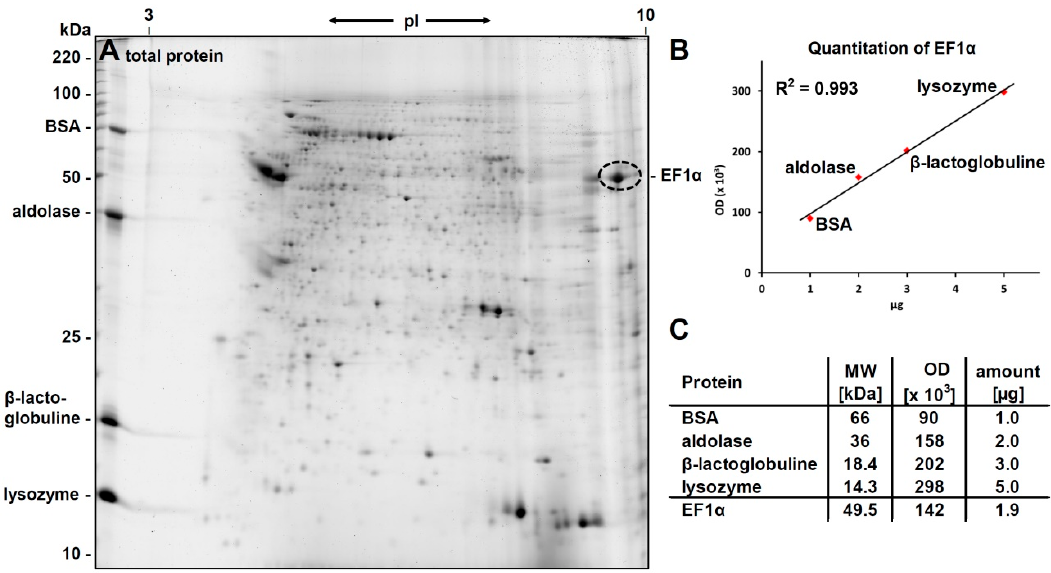
Figure 5. Quantitation of the extracted eEF1 α . ( A ) Gel stained with Flamingo for total protein visualization. To quantify individual spots by densitometric analysis, four proteins with specific amounts were run along the sample in the second dimension; ( B ) The plot shows the linear correlation of optical densities of the four proteins with their nominal amount; ( C ) The table displays the data for the calibration proteins and the derived amount of eEF1 α contained in 400 µg of total protein extract. For choline quantitation, tryptic peptides from 310 ng (approx. 6.26 pmol) eEF1 α were